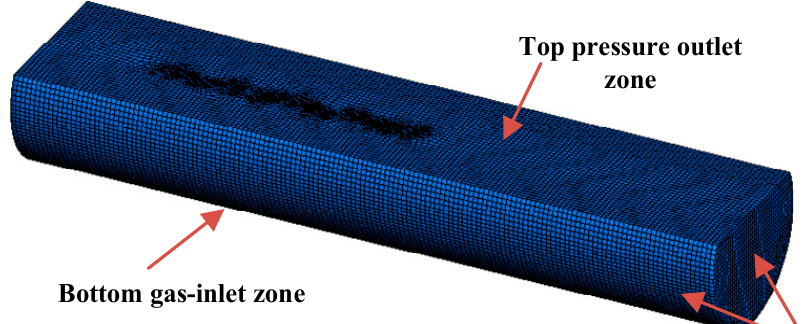
Figure 18. Geometry and mesh of bottom blown copper smelter water model.